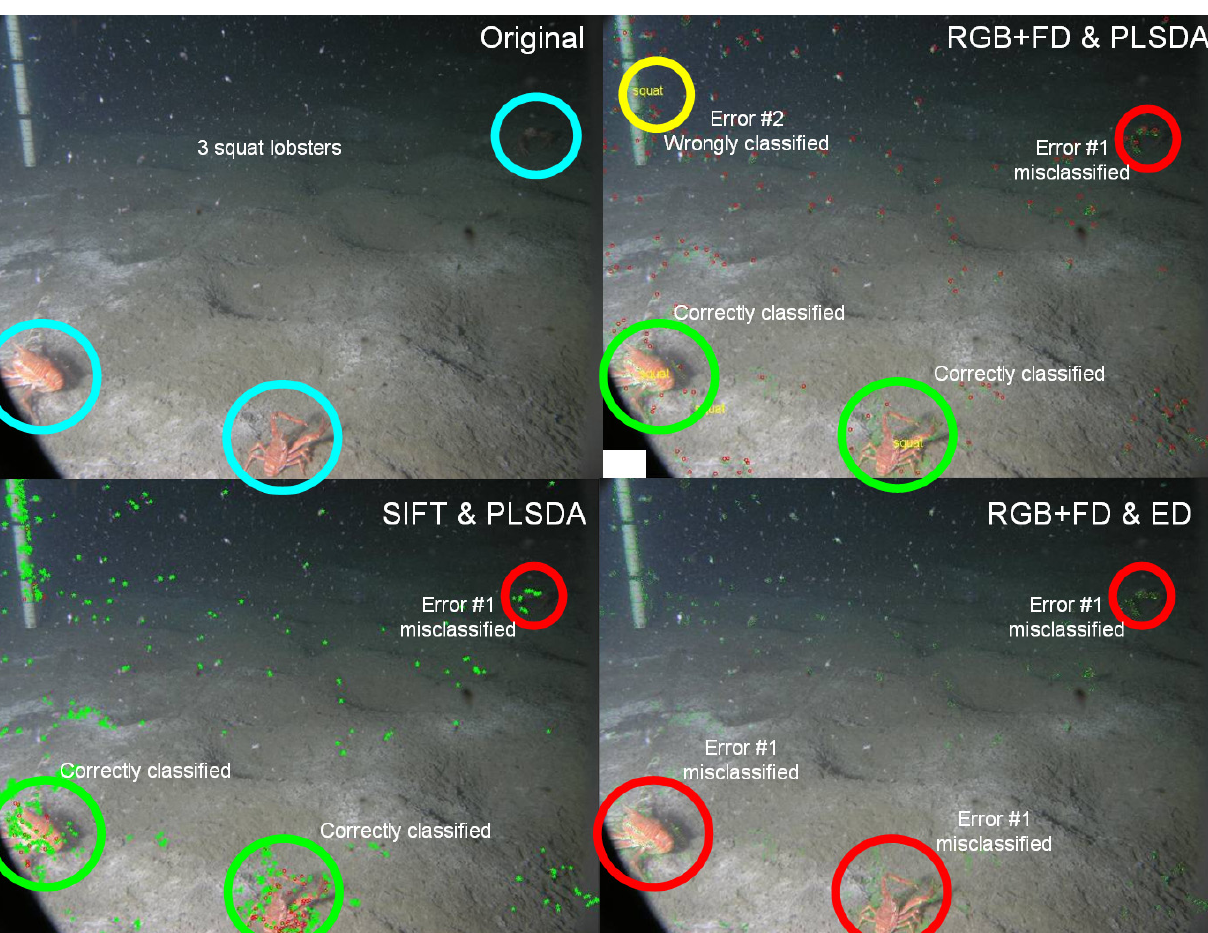
Figure 6. Example of different error typologies encountered during automated identification of squat lobsters ( Munida quadrispina ) in digital images taken at VENUS cabled observatory. An original image containing three individuals is presented along with different automated classification outputs in relation to the three different processing methods (see Figure 1): RGBv+FD and PLSDA; SIFT and PLSDA; RGBv+FD and ED. Blue circles highlight the animals inside the original image. Green circles represent correctly classified lobsters. Red circles indicate non-classified but present (misclassified; Error Type-1) animals. Yellow circles indicate wrongly classified (detected but not present; Error Type-2)